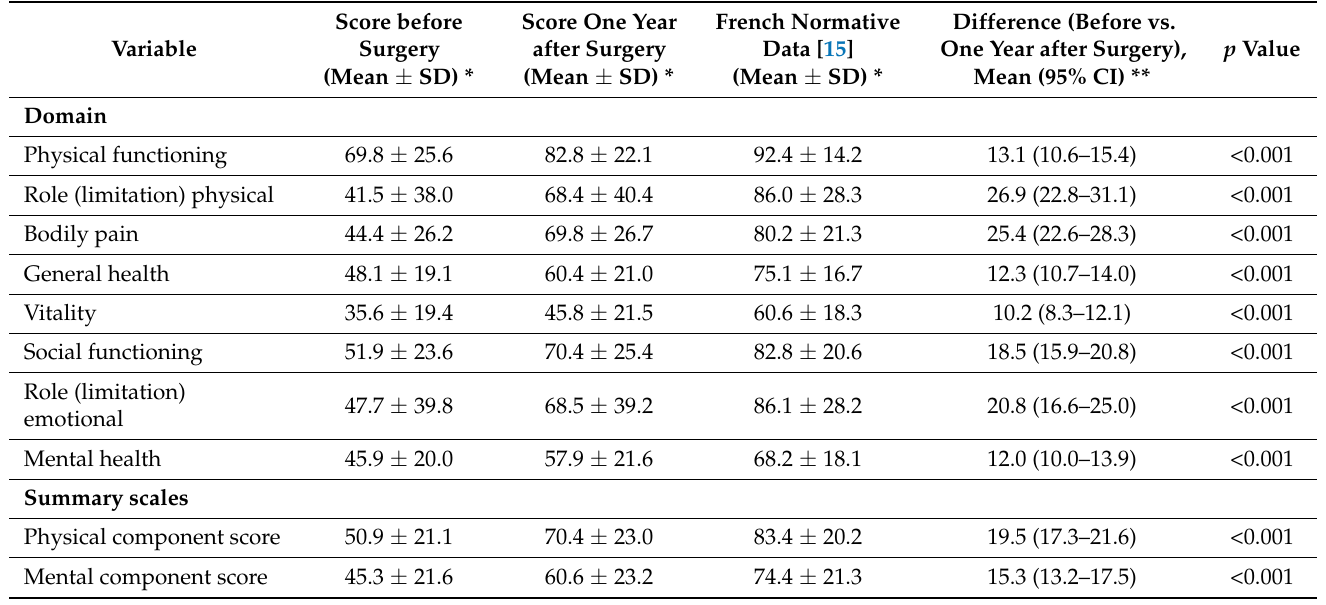
Table 5. Short Form-36 quality of life scores before and one year after surgery.